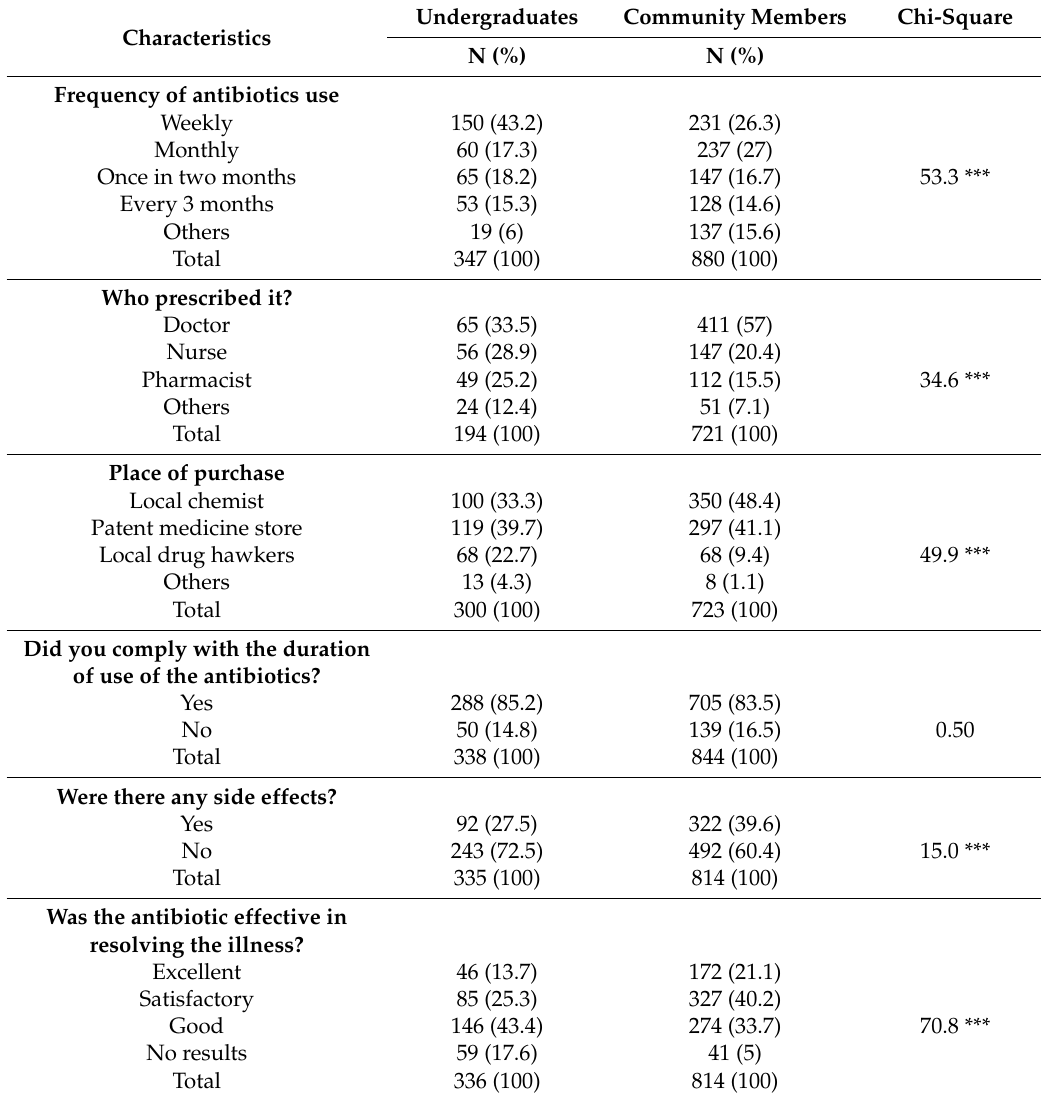
Characteristics of undergraduate students and community members indulging in self-medicated